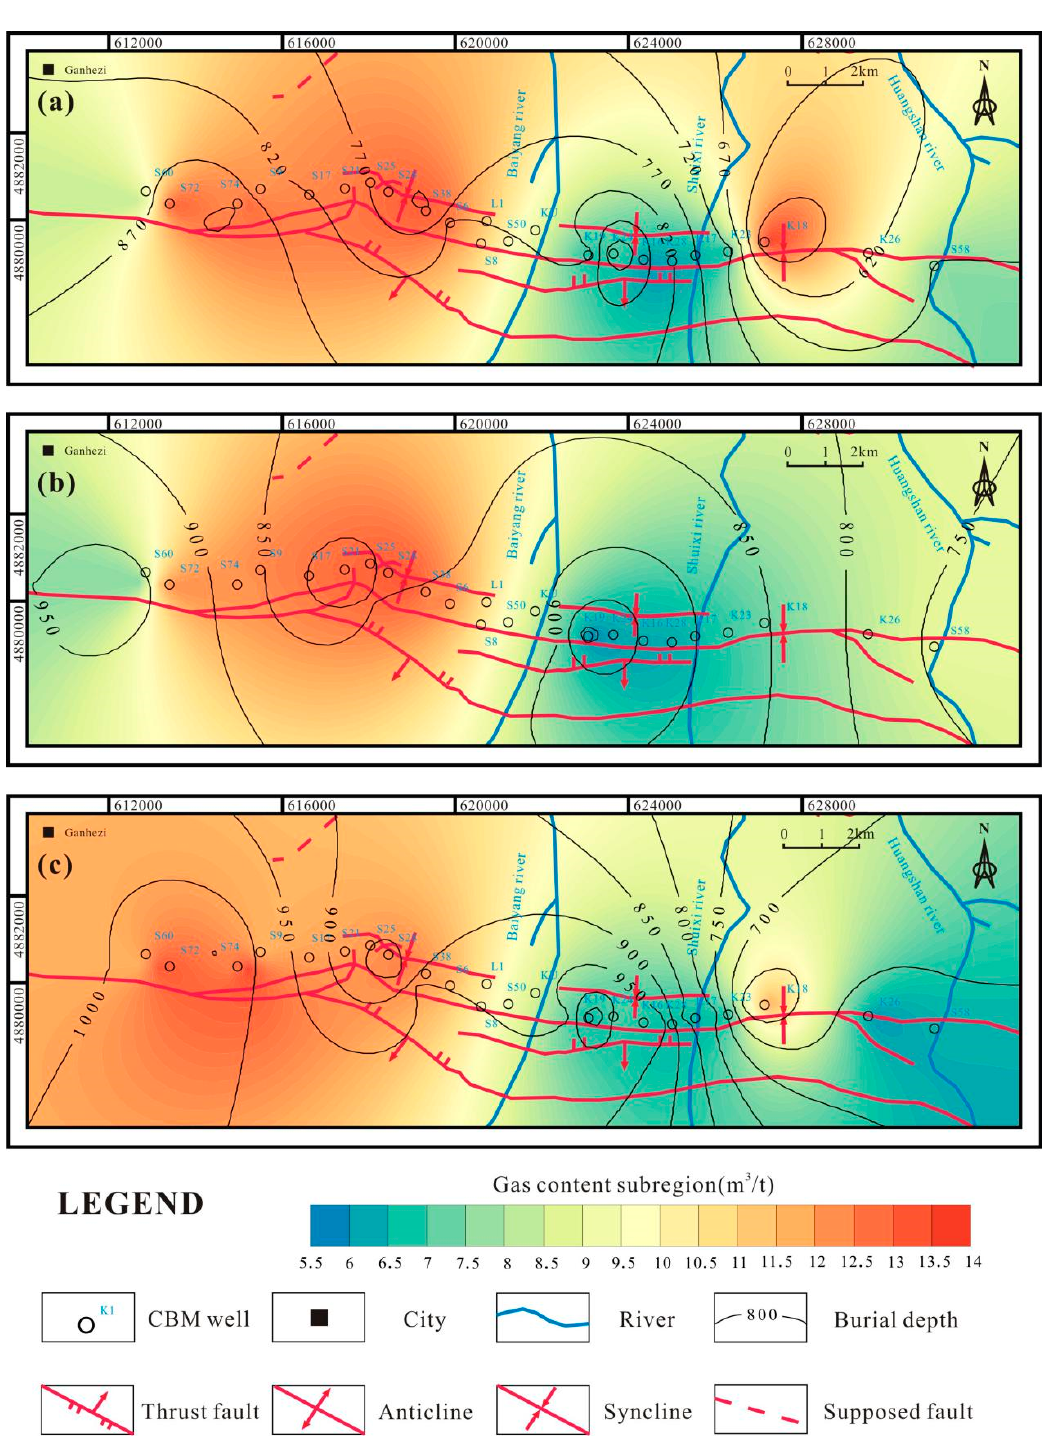
Figure 8. Relationship between gas content and burial depth of Nos. 39 ( a ), 41 ( b ), and 42 ( c ) coal seams in the Ergonghe syncline (units of contour lines: m for burial depth and m 3 /t for gas content with different color areas).